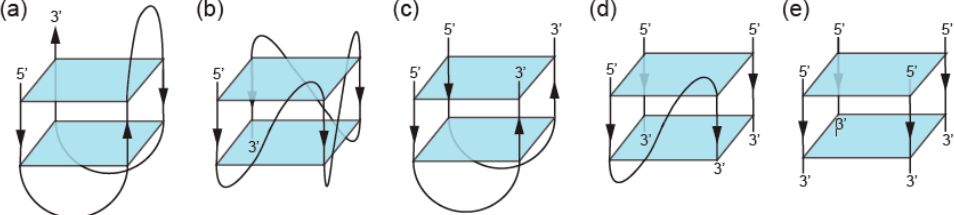
Figure 3. Formation of GQs from different numbers of strands. ( a ) Intramolecular (unimolecular) GQ with antiparallel strands. ( b ) Intramolecular (unimolecular) GQ with parallel strands. ( c ) Bimolecular (dimeric) GQ. ( d ) Trimolecular (trimeric) GQ. ( e ) Tetramolecular (tetrameric) GQ. Note that each of these structures can in principle contain all parallel strands, all antiparallel strands, or a mix of parallel and antiparallel strands.